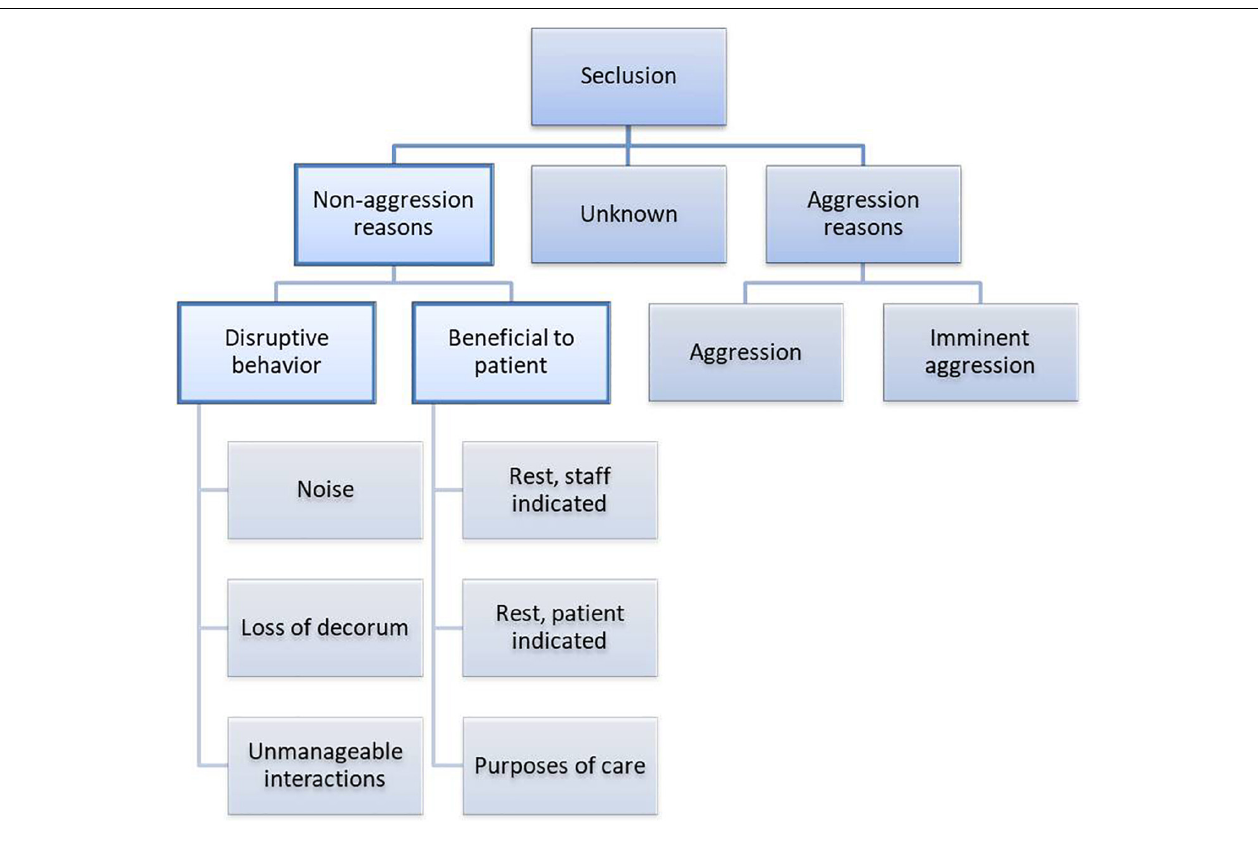
FIGURE 2 | Flowchart of the reasons for